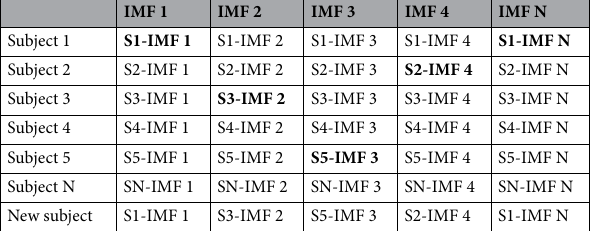
Table 1. Generation of an artificial subject. The IMFs in bold, one of each order and coming from several subjects, are added together to generate an artificial subject.